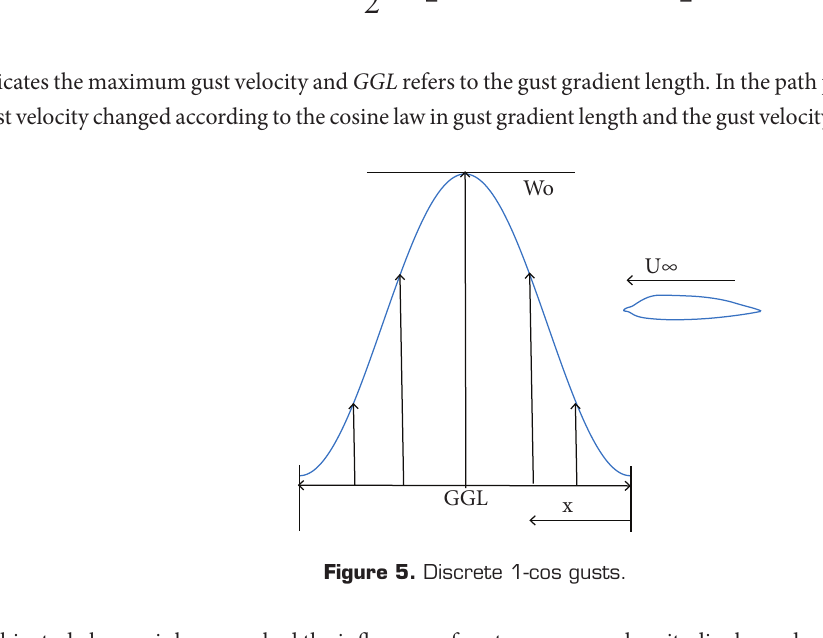
Figure 5. Discrete 1-cos gusts. Owing to this study has mainly researched the influences of gust response on longitudinal aerodynamic characteristics of the UAV, the half-model of the UAV was used for calculation in order to reduce the calculation amount. Setting the coordinate origin at the head of the UAV. The grid generation procedures were an important issue